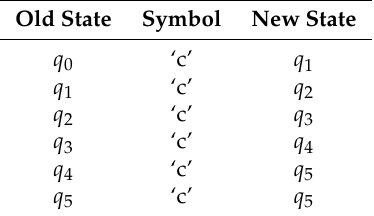
Figure 11. Overview of a state machine. The process reads the first character and, for every “c” found, a transition is realized. Table 1. The relation among the current state, the symbol being read, and the after